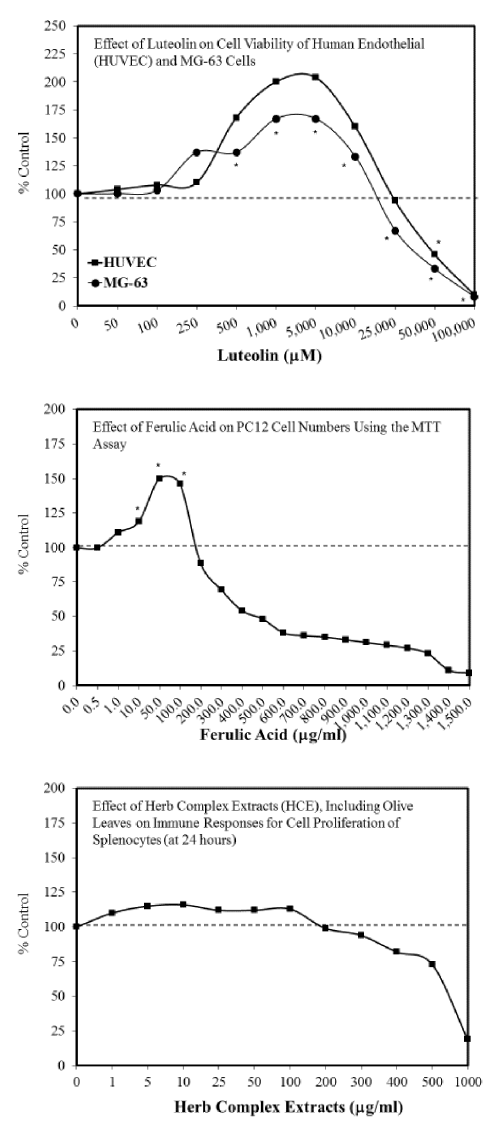
Figure 3. Upper panel: Effect of luteolin on cell viability of human endothelial (HUBEC) and MG ‐ 63 cells (adapted from [104,105]). Middle panel: Effect of ferulic acid on PC12 cell numbers using the MTT assay (adapted from [106]). Lower panel: Effect of Herb Complex Extracts (HCE), including Olive Leaves on Immune Responses for Cell Proliferation of Splenocytes (at 24 h) (adapted from [107]). All graph data are reported respect to control rapresented with dotted line.